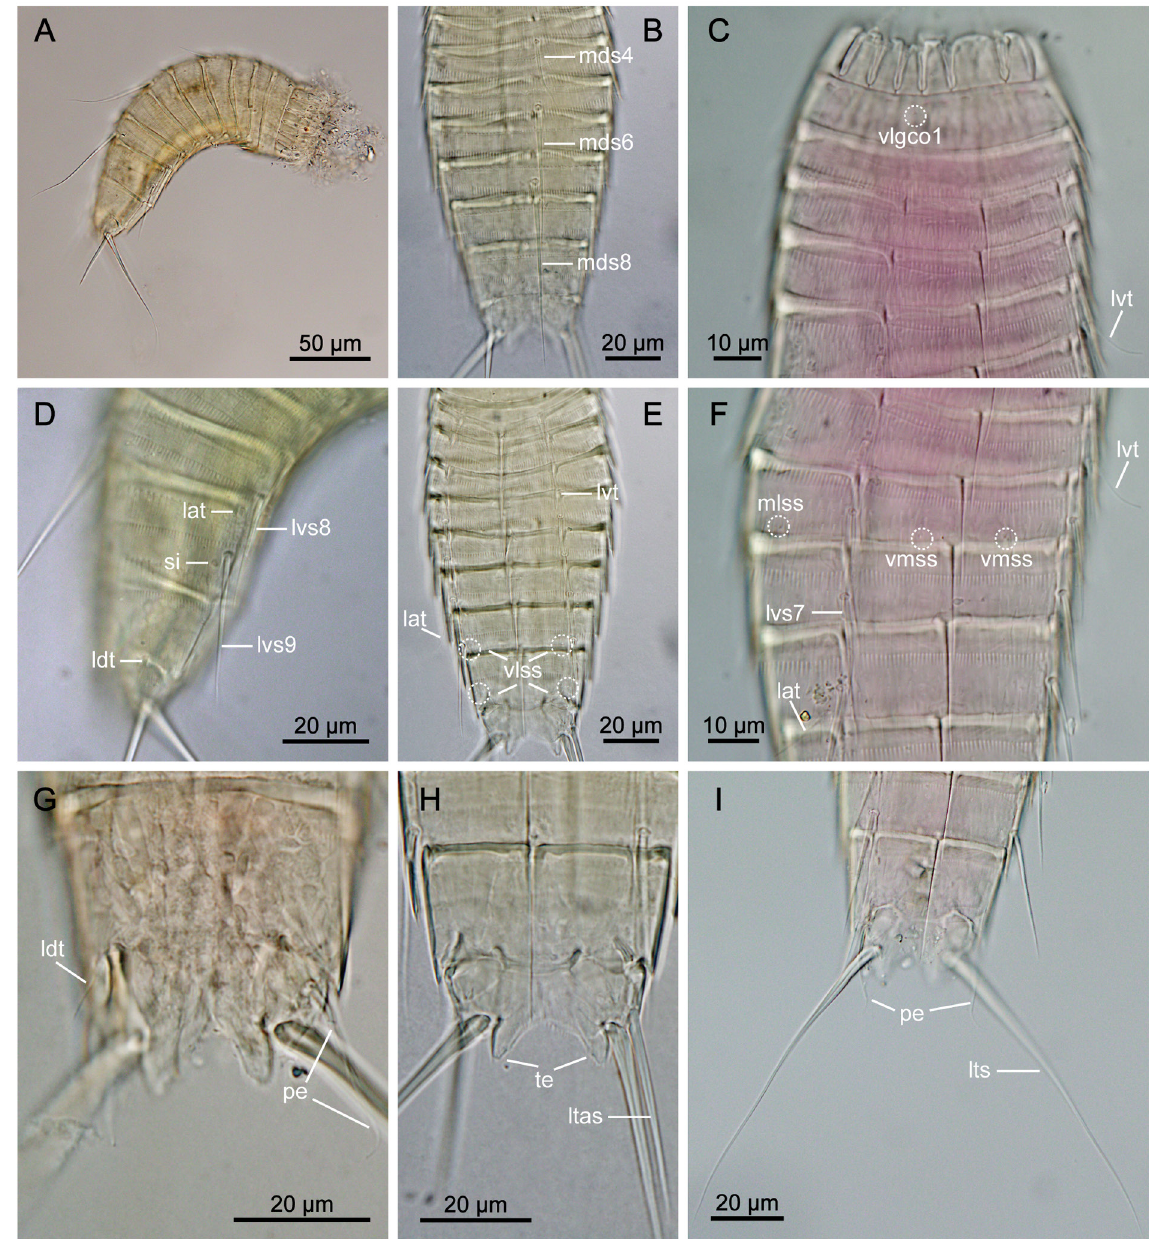
Fig. 21. Light micrographs showing overview and details of Echinoderes samwisei sp. nov. A, D . ♀, paratype (NHMD-917299). B, E, H . ♀, paratype (NHMD-917302). C, F, I . ♂, holotype (NIWA-159418). G . ♂, paratype (NHMD-917300). A . Lateral overview. B . Segments 3 to 11, dorsal view. C . Segments 1 to 5, ventral view. D . Segments 7 to 11, lateral view. E . Segments 2 to 11, ventral view. F . Segments 5 to 8, ventral view. G . Segments 10 to 11 of male, dorsal view. H . Segments 9 to 11 of female, ventral view. I . Segments 9 to 11 of male, ventral view. Abbreviations: see Material and